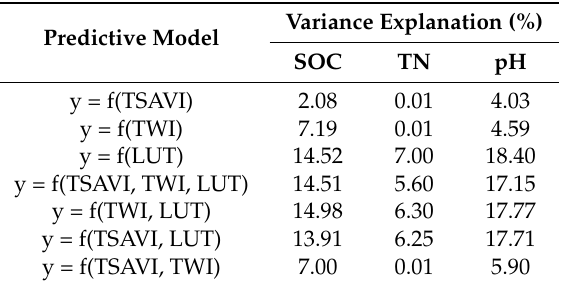
Table 2. Variance explanation for models.